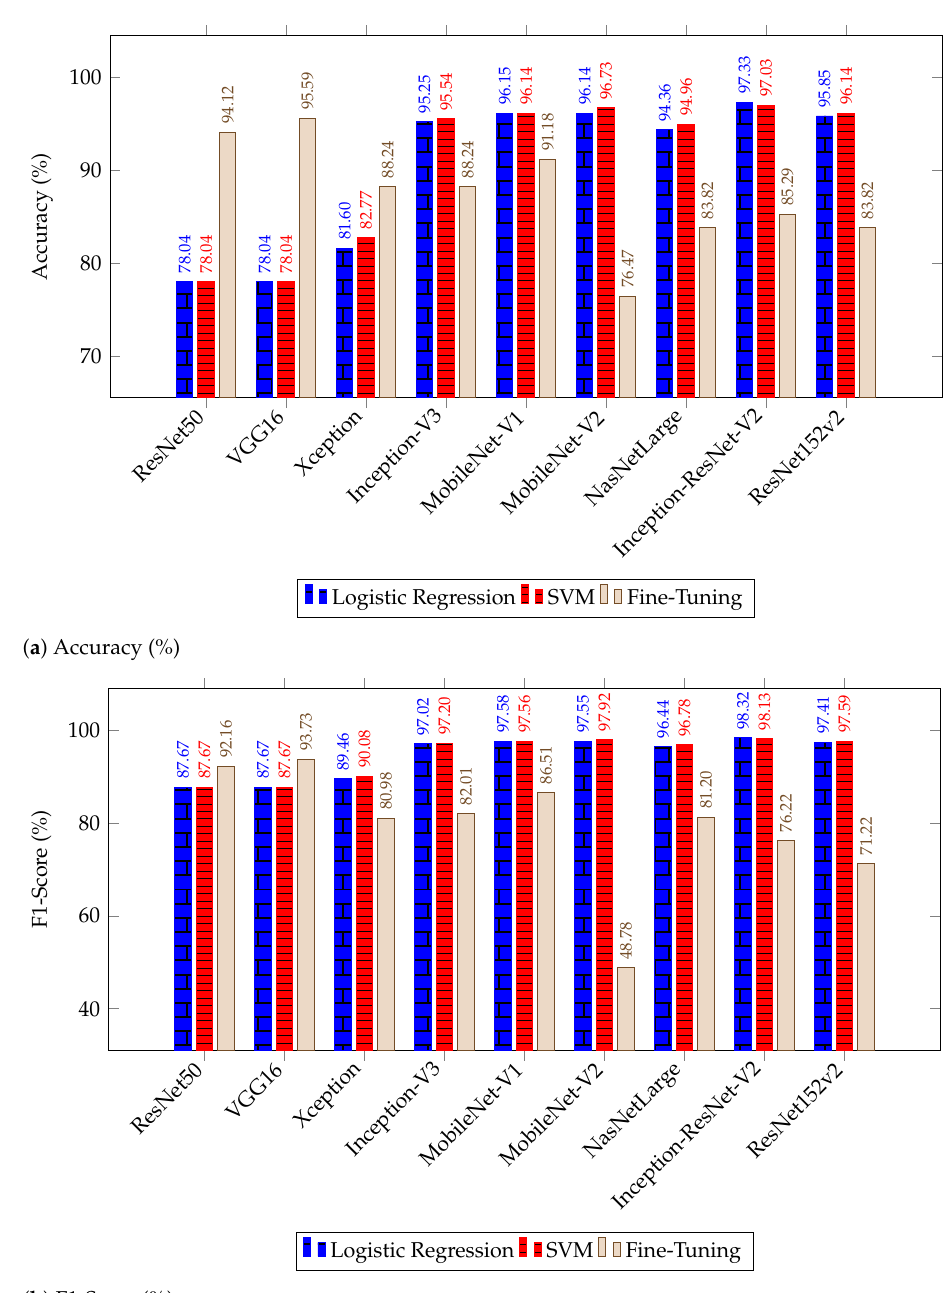
Figure 3. Accuracy ( a ) and F1-score ( b ) comparison of the results obtained in our proposed pipeline using transfer learning and fine-tuning on